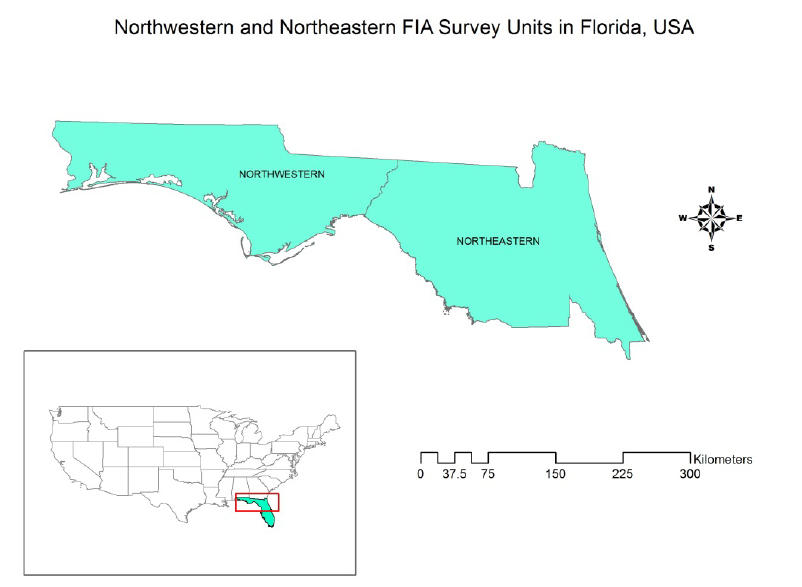
Figure 1. The northeastern and northwestern Forest Inventory Analysis (FIA) survey units and study area in the northern portion of the State of Florida,